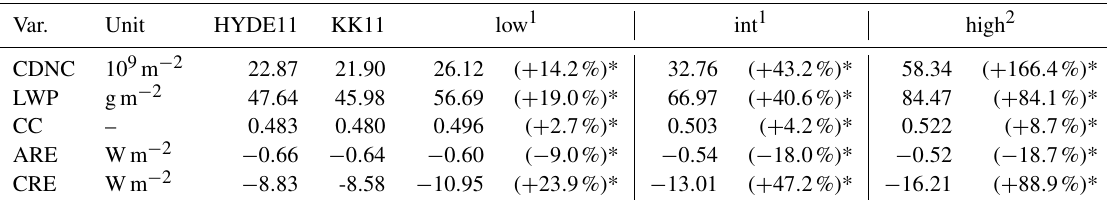
Figure 7. The impact of anthropogenic aerosol emissions for the low (a, d, g) , intermediate (b, e, h) , and high emission scenarios (c, f, i) . Shown are differences in aerosol radiative effect (a–c) , cloud radiative effect (d–f) , and land surface temperature (g–i) . Statistically significant changes (5% significance level; N = 20) are hatched. Note that the SSTs in the simulations are fixed. Table 5. Annual mean impact of anthropogenic aerosol emissions on different variables averaged over the study domain (10 ◦ W to 50 ◦ E and 20 to 60 ◦ N): cloud droplet number concentration (CDNC), liquid water path (LWP), cloud cover (CC), aerosol radiative effect (ARE), and cloud radiative effect (CRE) for all simulations except no_human. Significant (5% significance level; N = 20) changes compared to the respective reference are marked with an asterisk